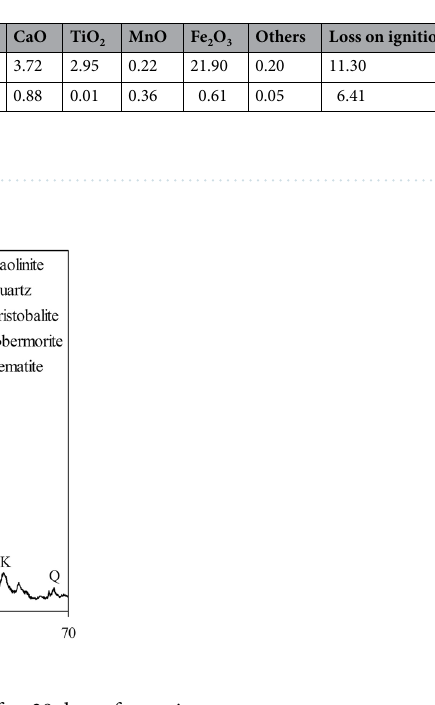
Figure 9. Mineralogical composition of the Mixture 1 after 28 days of cure